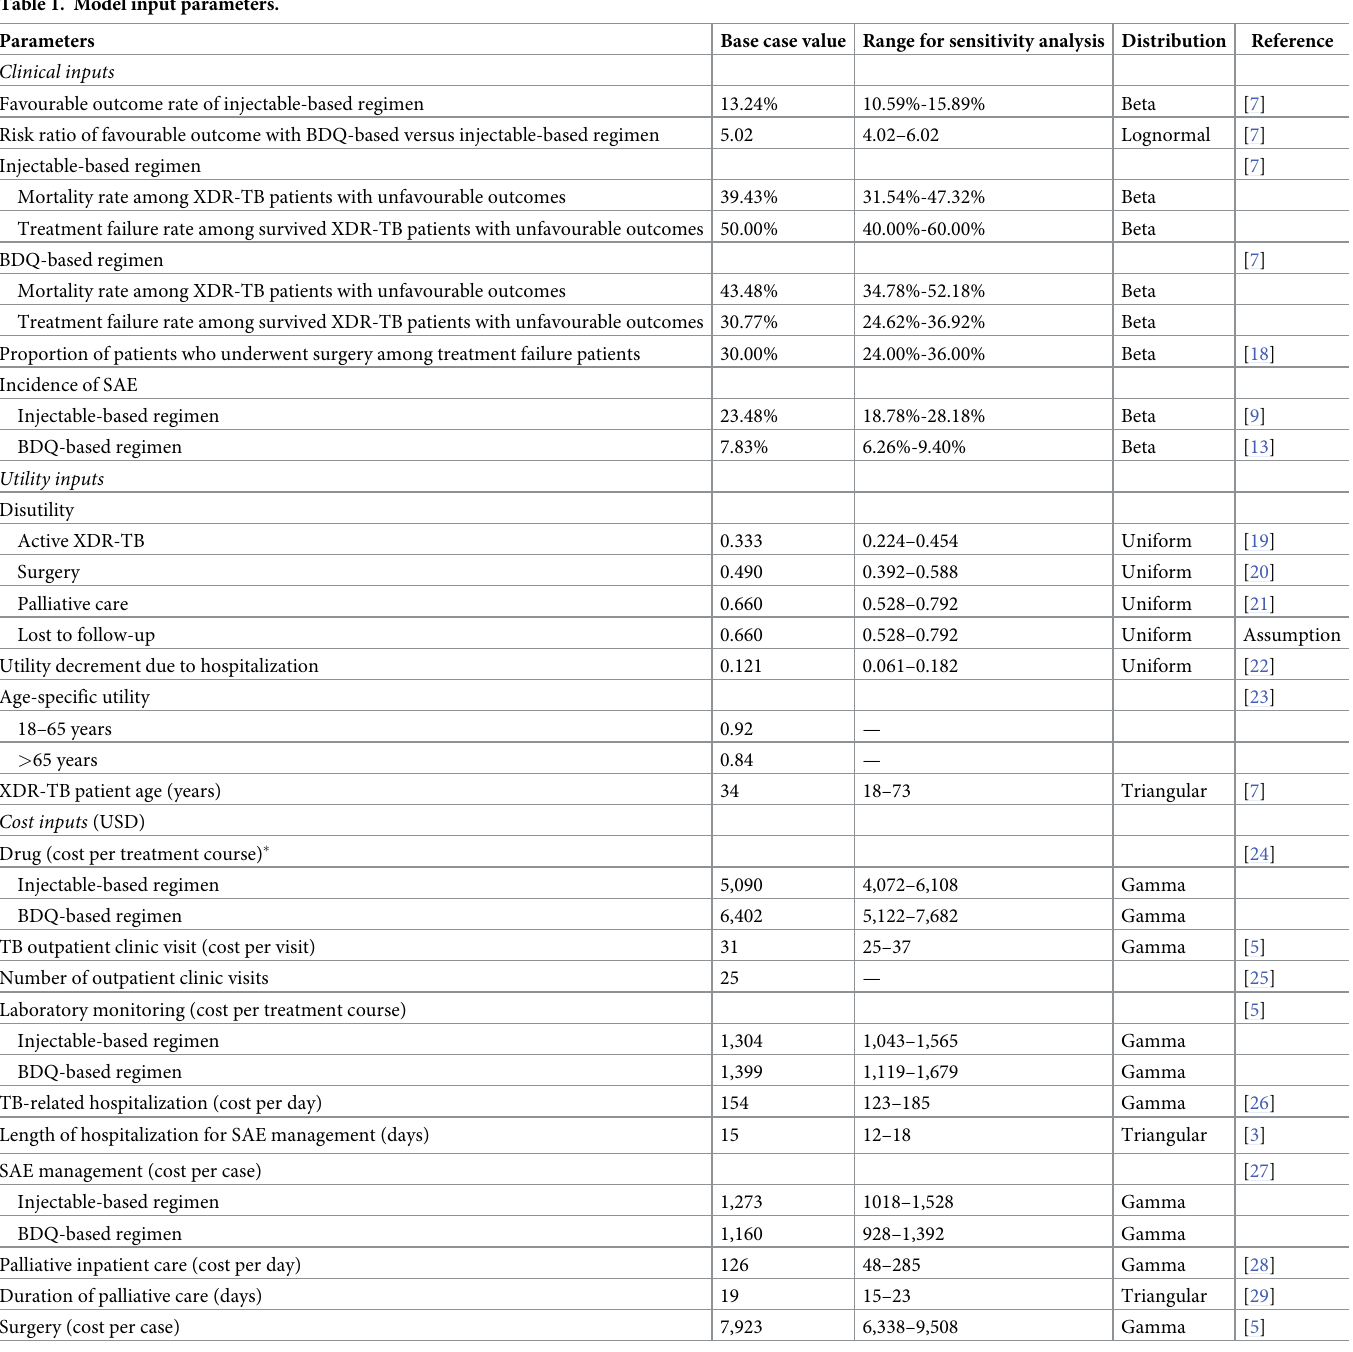
Table 1. Model input